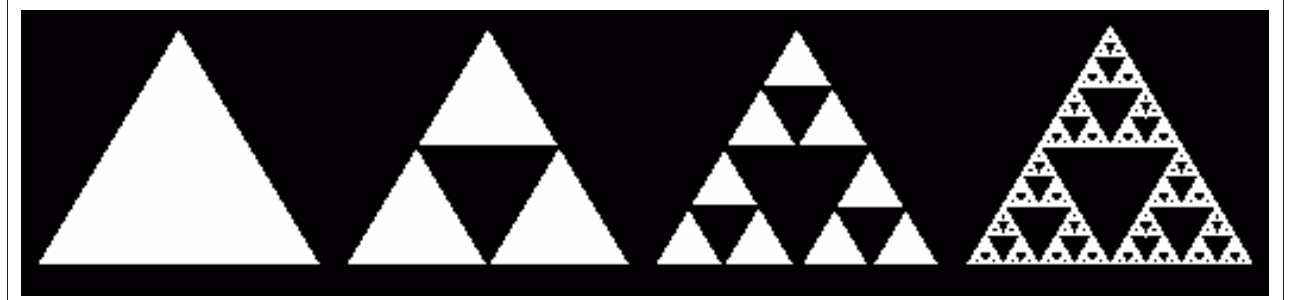
FIGURE 2: The Sierpinski